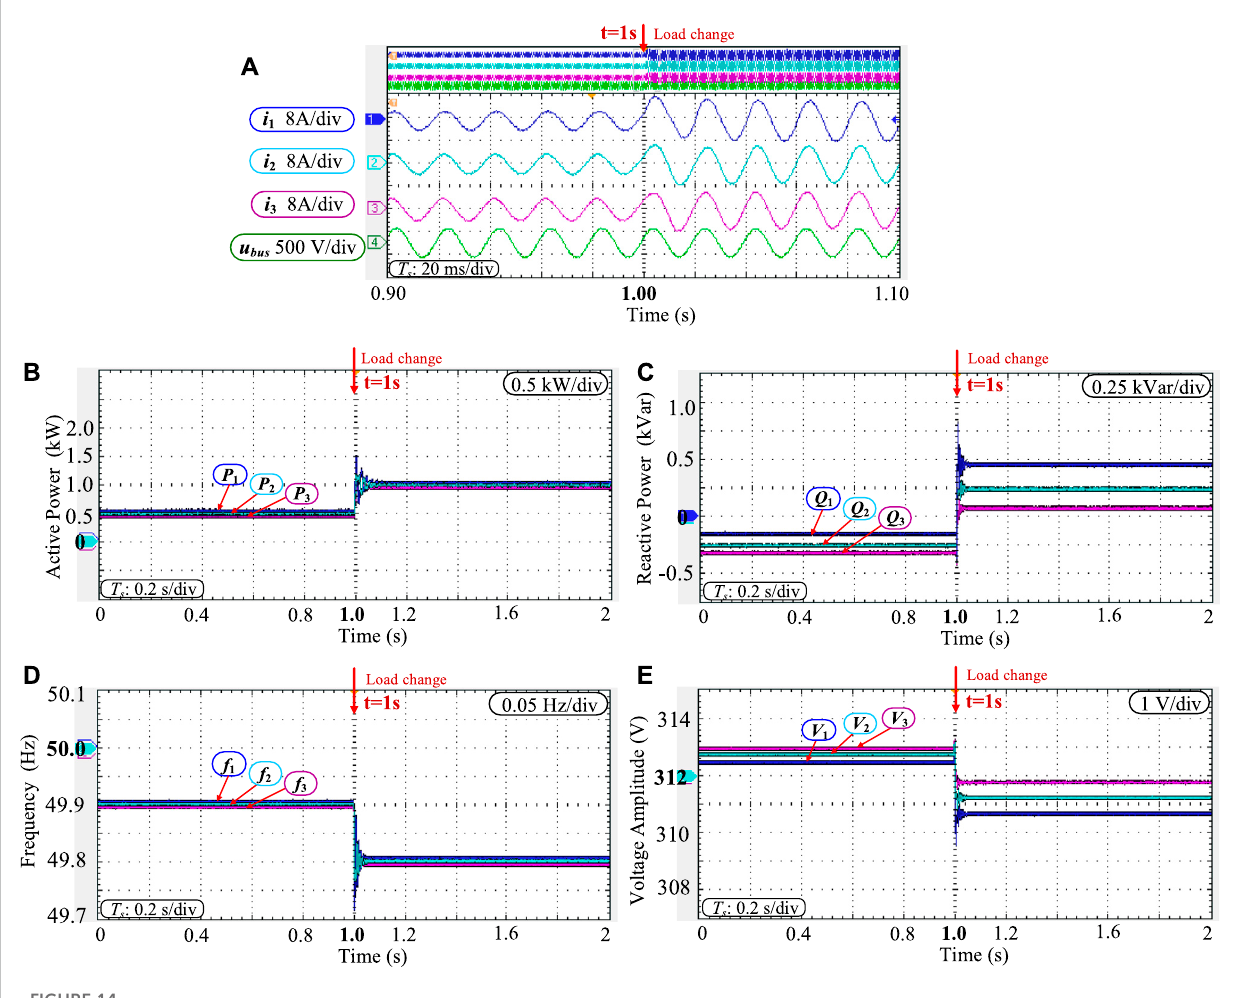
FIGURE 14 Experimentalresultsunderhighly-resistivelinecharacteristics. (A) outputwaveforms; (B) activepower; (C) reactivepower; (D) frequency; (E) voltage